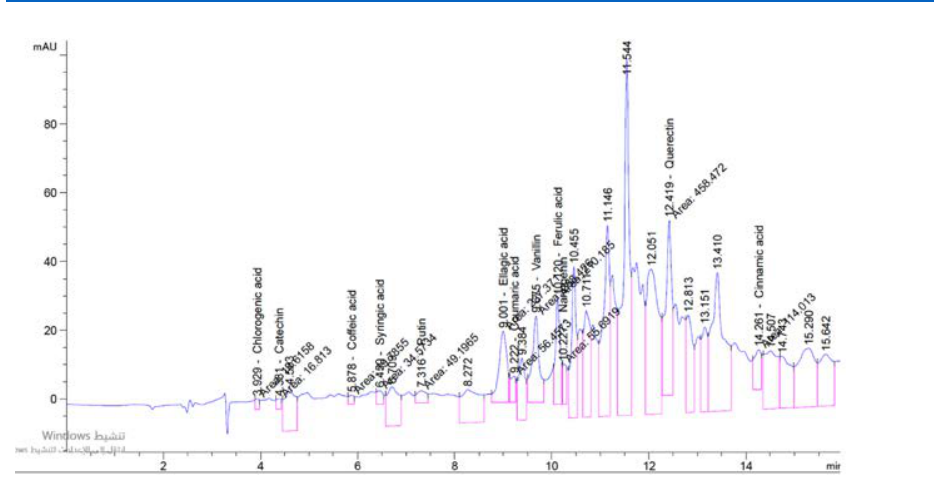
Fig. 4. Commiphora myrrh resin chloroform extract (Conc. 15 mg /ml) extract of Commiphora myrrh seed extract have potent effect against bacteria and fungi 35